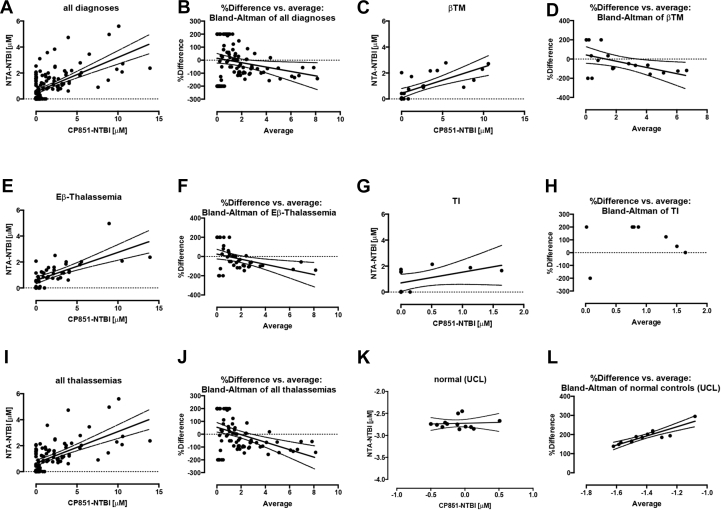
Comparison and Bland-Altman analysis of agreement of NTA and CP851-NTBI methods in different diagnosis groups. Negative values by both methods have been treated as zero. (A-B) all diagnoses; slope P < 0.0001. (C-D) beta-thalassemia major; slope P < 0.0001. (E-F) E-beta-thalassemia; slope P < 0.0001. (G-H) thalassemia intermedia; slope not significant. (I-J) all thalassemias; slope P < 0.0001. (K-L) normal volunteers; slope not significant. All Bland-Altman analyses show lack of acceptable agreement except for the normal samples where the low-scatter systematic bias could be corrected for using the formula (239.1 ± 35.12[%]*avgNTBI[uM]+527.3 ± 50[%]) (27). NTBI, nontransferrin-bound iron; NTA, nitrilotriacetate.